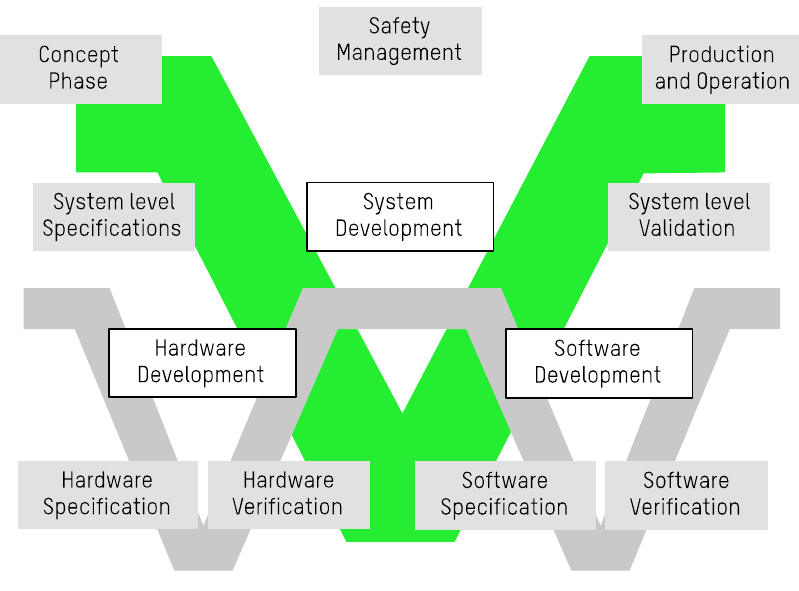
Figure 1. Safety-oriented design methodology.